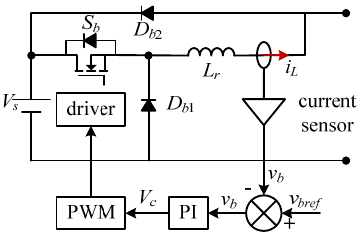
Figure 2. The control diagram of the current source converter.